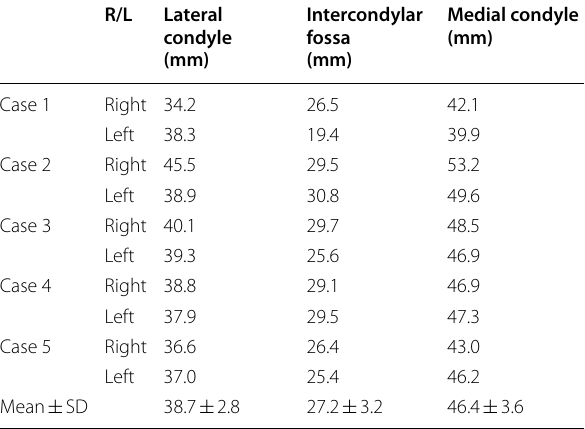
Table 3 Length between the distal femoral point and the attachment site of the posterior capsule